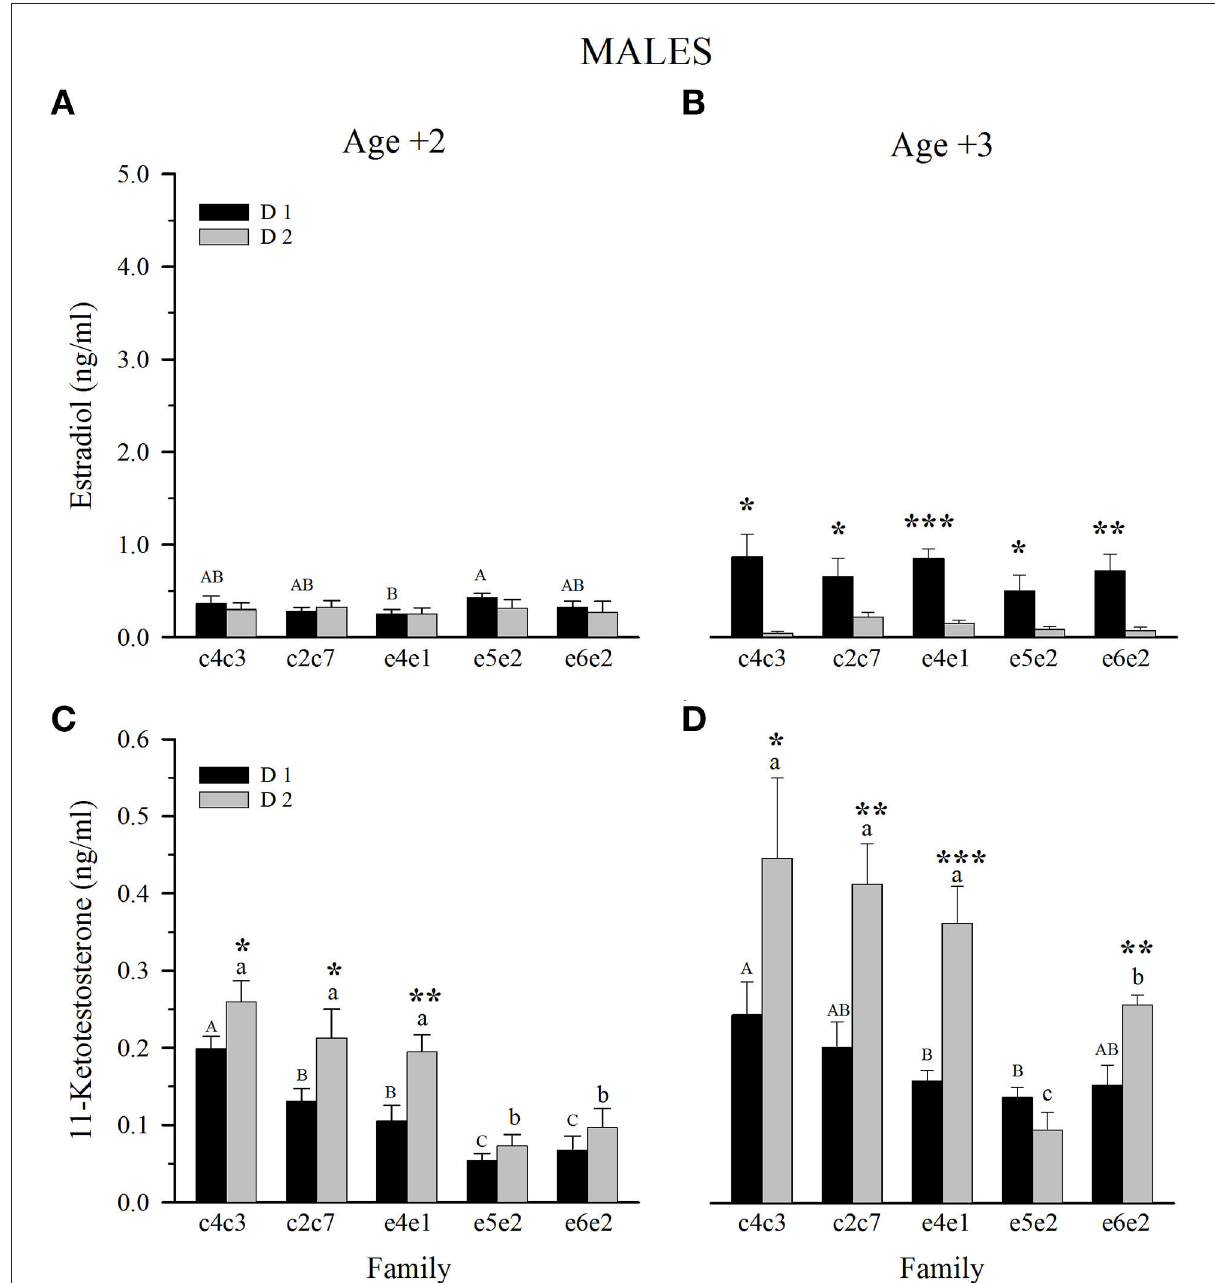
FIGURE4 Plasma levels at spawning season of estradiol (A, C) and 11-ketotestosterone (B, D) in 2 and 3-year-old males fed control (D1) or experimental diet (D2). Values are the mean ± SEM. Different capital letters indicate significant differences between families fed D1. Different lowercase letters indicate significant differences between families fed D2. Asterisks indicate significant differences between dietary groups within each family (Student’s t -test, * P < 0.05, ** P < 0.01, *** P < 0.001).